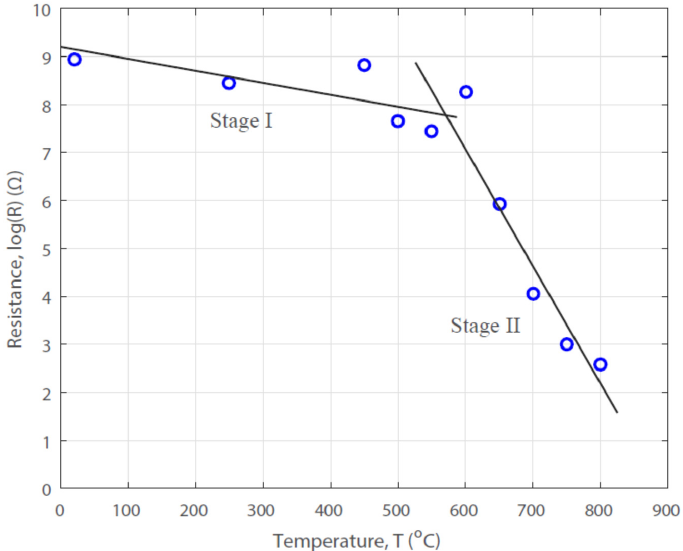
Figure 6. Logarithmic resistance vs. temperature showing two different stages of pyrolysis kinetics.